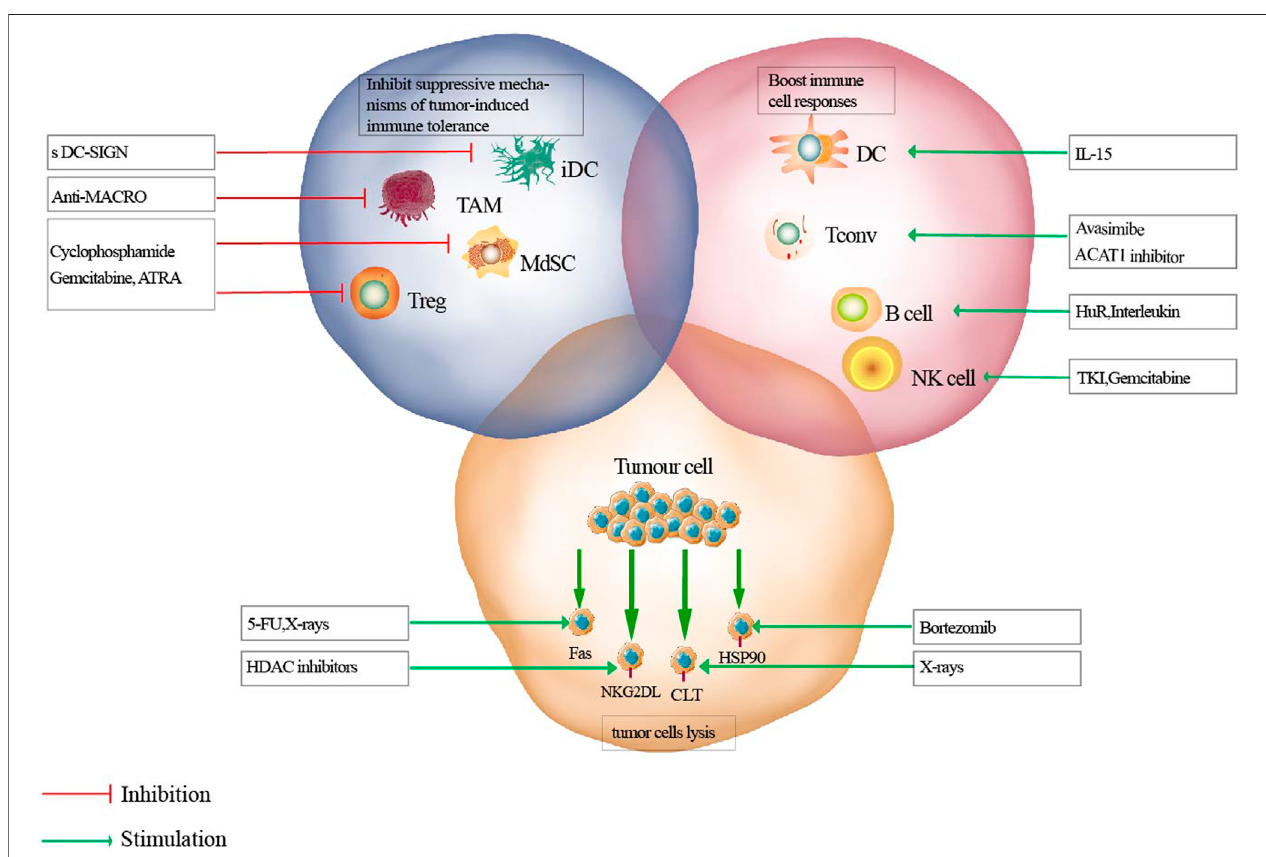
FIGURE 1 | Mechanisms of effective anti-tumor therapies on immune responses. Antitumor therapeutics can eliminate immunosuppressive cells (blue circle), activate immune effectors (pink circle), or sensitize tumor cells to lysis (yellow circle). iDC, immature dendritic cell; TAM, tumor associated macrophage; MdSC, myeloid derived suppressor cells; Tconv, conventional T cell; ATRA, all-trans-retinoic acid; TKI, tyrosine kinase inhibitors.